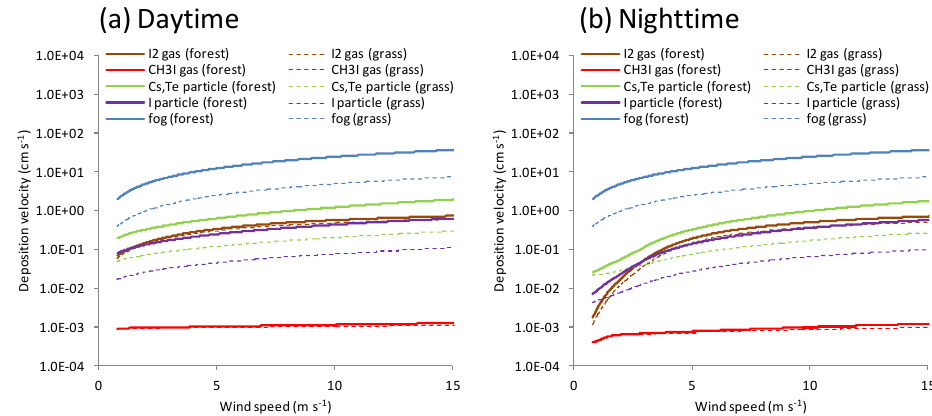
Figure A1. Changes in the modeled deposition velocity ( V d ) of gaseous and particulate radioactive substances and of fog water versus the horizontal wind speed over forest (solid lines) and grassland (dashed lines) surfaces (a) during the daytime and (b) nighttime for typical clear conditions. Input meteorological data are mainly from the surface weather stations in Fukushima Prefecture from 12 to 15 March, 2011 and show the following: 16 and − 1.5 ◦ C for air temperature, 21 and − 5 ◦ C for ground surface temperature, 800 and 0Wm − 1 for solar radiation, 30 and 70% for relative humidity during the daytime and nighttime,